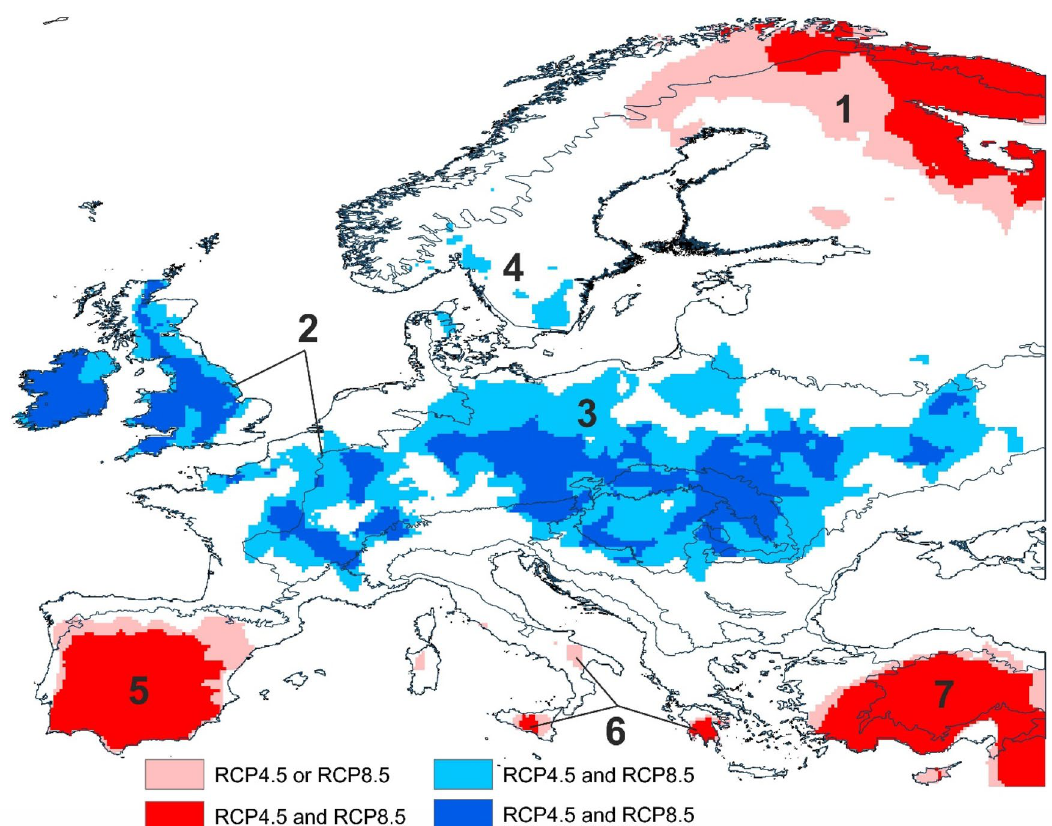
Figure 1. Continental-scale zones with significantly higher (blue) and lower (red) future climate stability, relative to background climate change. Coloured zones are likely to persist in all periods considered here Fig. 2. Maps were created in R v. 4.0.4. (R Core Team, Vienna, Austria) and ArcGIS Desktop v. 10.7 (Esri, California, USA). The final layout was created in ArcGIS Desktop v. 10.7 (Esri, California, USA) and CorelDraw v. 20.1.0.707 (2018 Corel